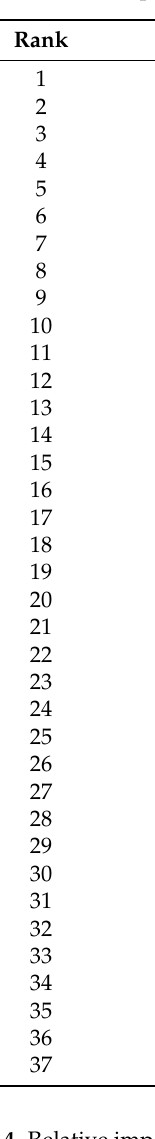
Table 3. Relative importance index for barriers.